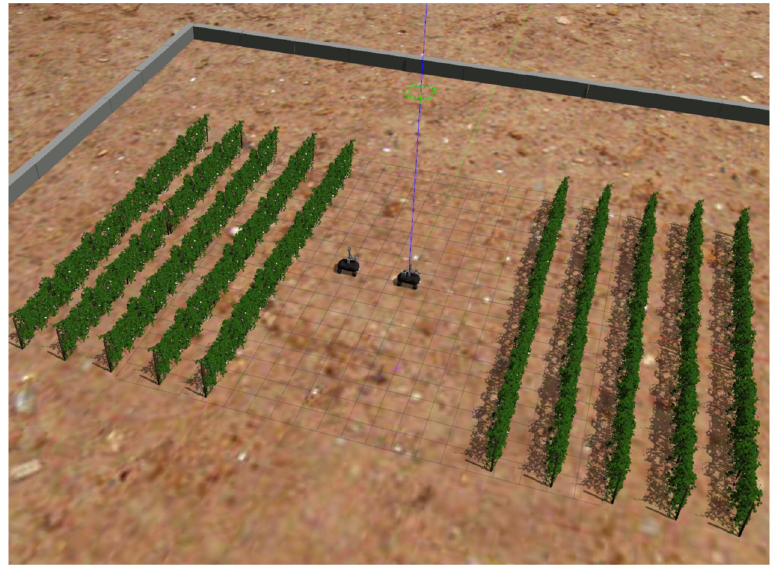
Figure 1. The simulated